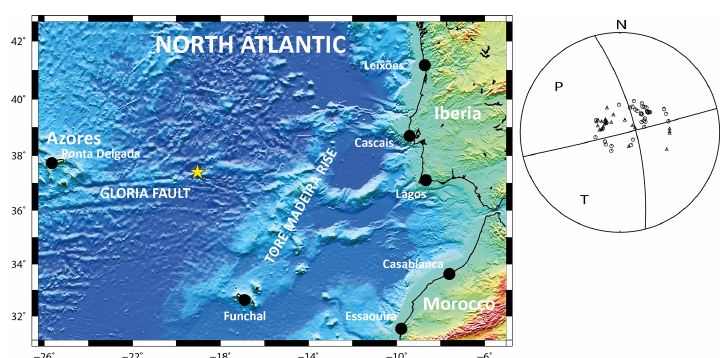
Figure 1. General overview of the Northeast Atlantic at the latitude of Iberia and focal mechanism of the earthquake. The yellow star represents the epicentre of the earthquake. Black dots show the location of the tide